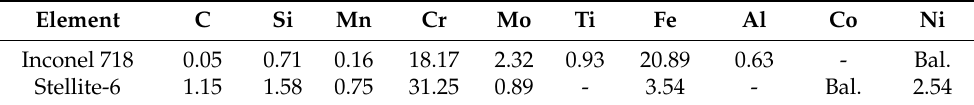
Table 1. Composition of Inconel 718 and Stellite-6 powder (wt.%).